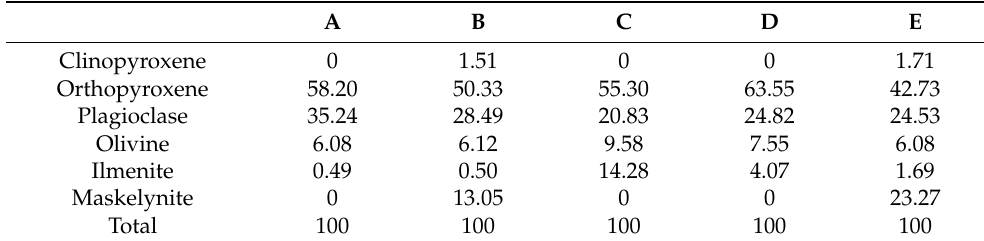
Table 3. Mineral abundances are estimated from NWA 8687 spectra (in